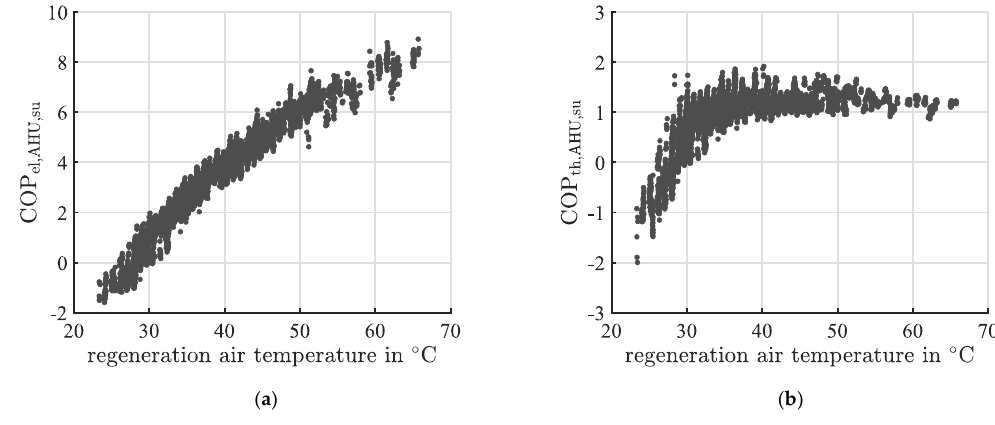
Figure 4. ( a ) Electrical COP of the air handling unit during summer operation at dehumidification